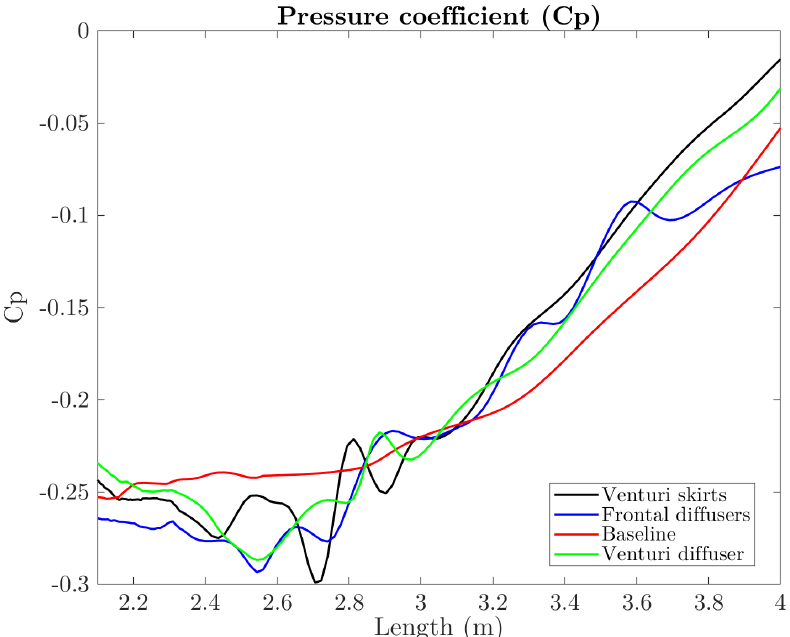
Figure 21. Pressure coefficient distribution along the symmetry plane of the rear